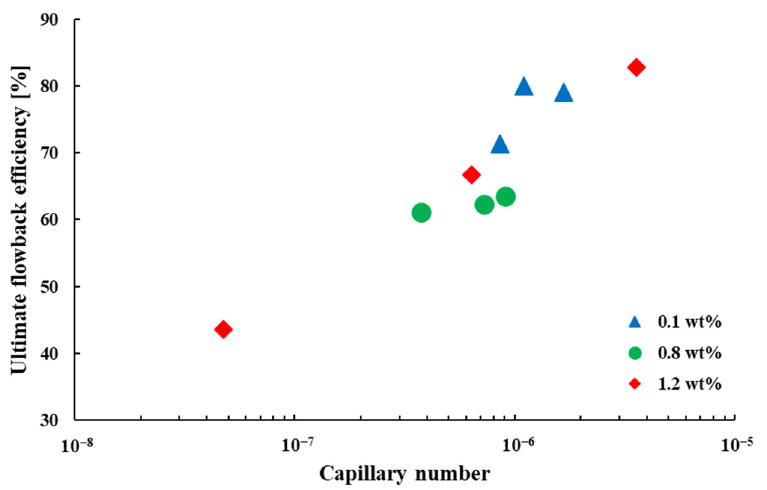
Figure 17. Relationship between the ultimate flowback efficiency of fracturing fluid and capillary number.